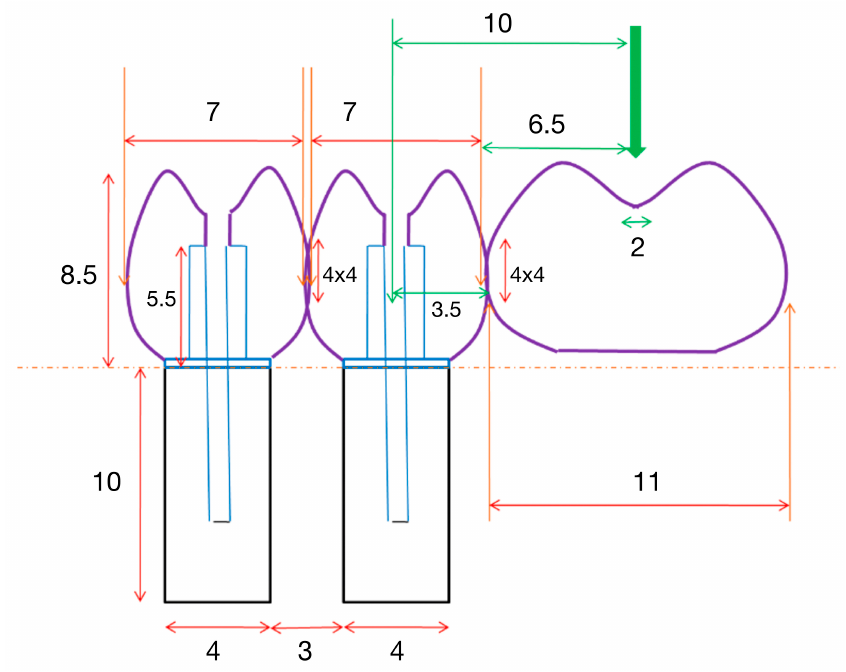
Figure 1. Specimen design. Measurements in millimeters.